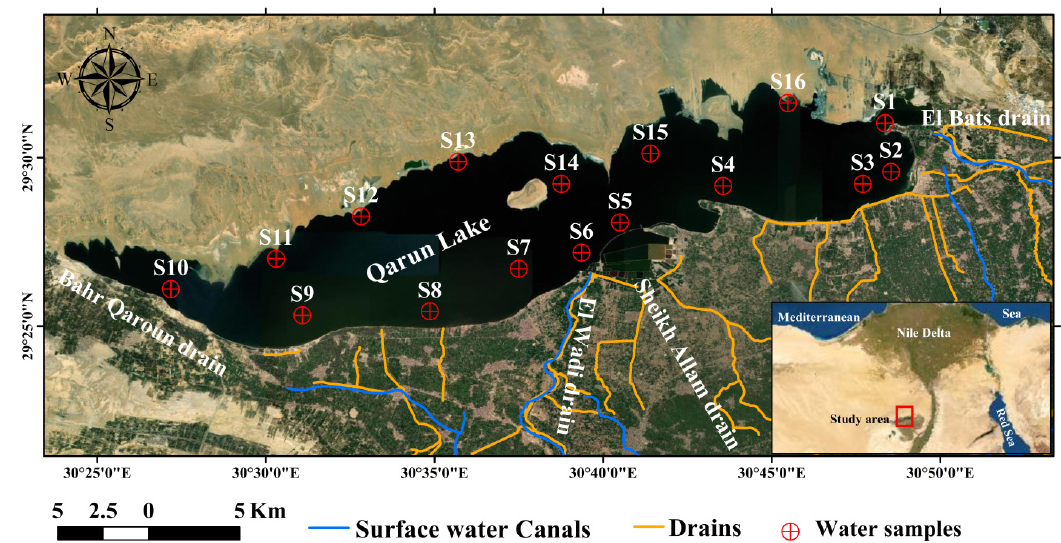
Figure 1. Location map of Lake Qaroun and sampling stations throughout the entire lake. S is abbreviation of the site.